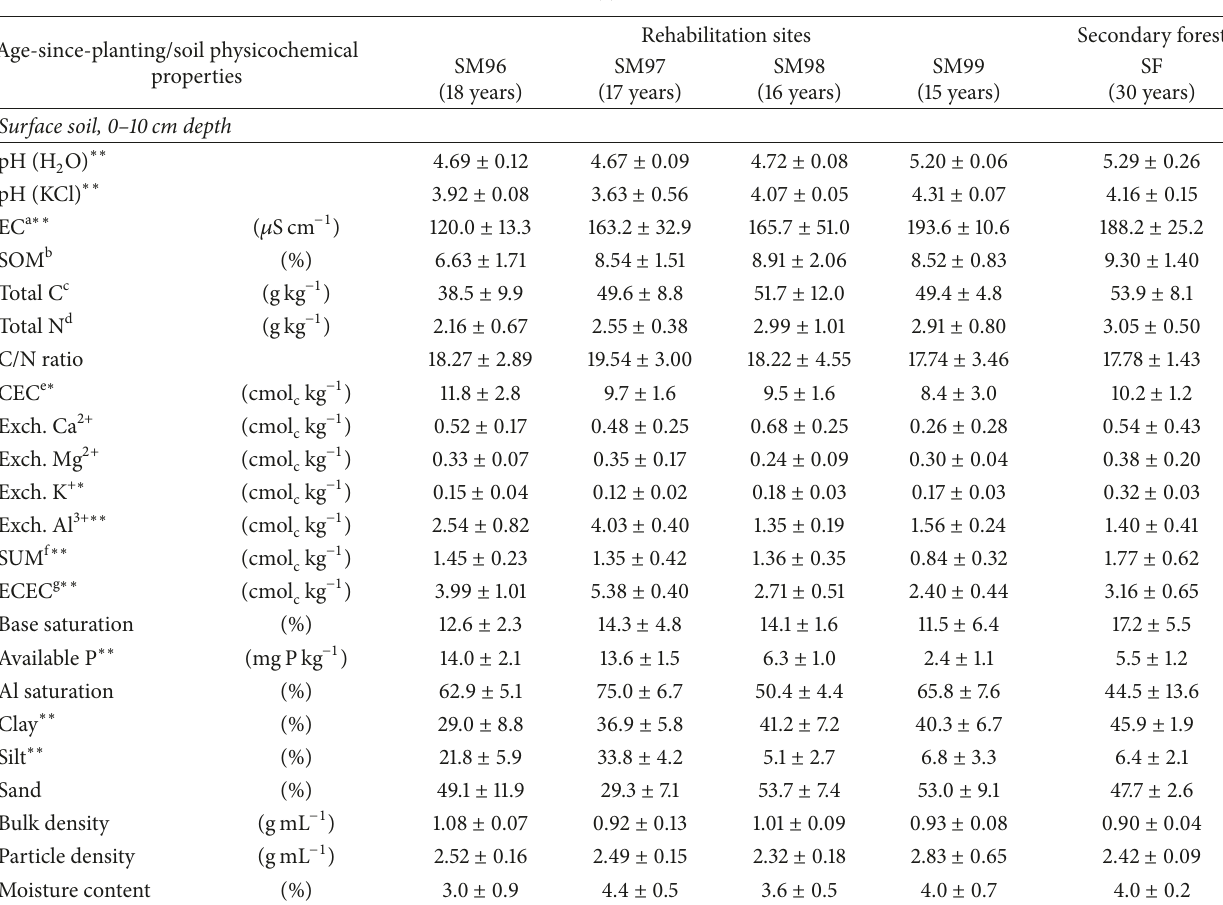
Table 2: (a) Means and standard deviation of surface soil physicochemical properties at rehabilitation sites (SM96, SM97, SM98, and SM99) and secondary forest (SF). (b) Means and standard deviation of subsurface soil physicochemical properties at rehabilitation sites (SM96, SM97, SM98, and SM99) and secondary forest